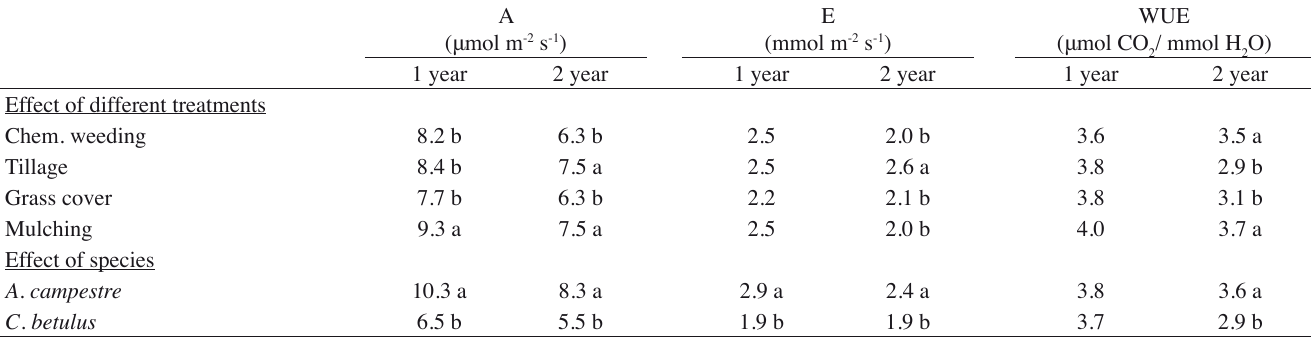
Table 5 - Effect of soil management technique and species on net assimilation (A, µmol*m -2 *s -1 ), transpiration (E, mmol*m -2 *s -1 ) and Water Use Efficiency (WUE, µmol CO /mmol H O). Data are the average of two (the first year) and four (the second year) measurement campaigns 2 2